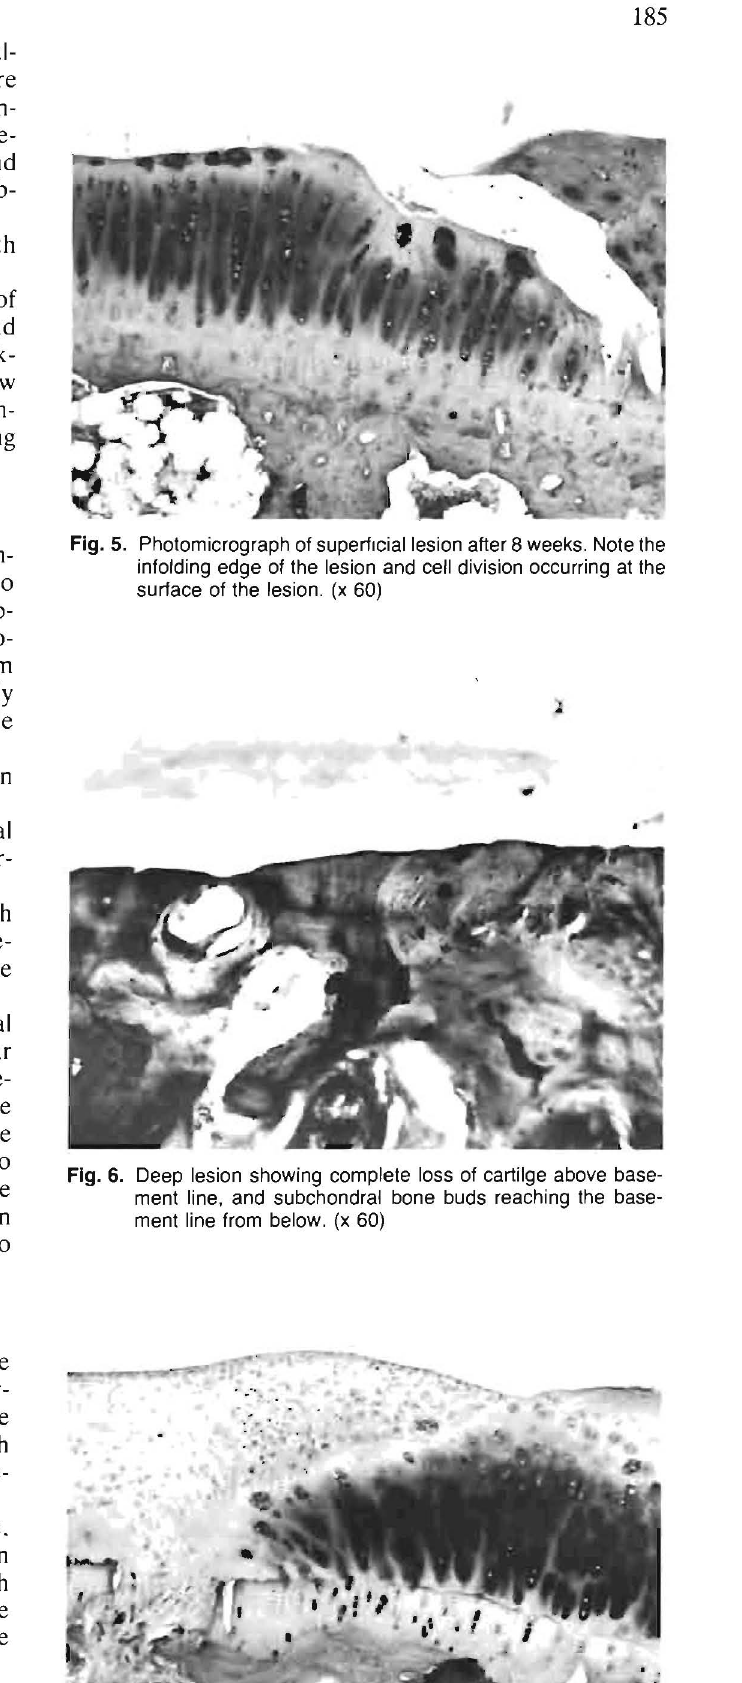
Fig. 7. Connective tissue from the subchondral marrow spaces in vading the lesion and undergoing metaplasia to fibrocarti lage. Note the firm bonding with hyaline cartilage at the edge of the lesion. (x 60).